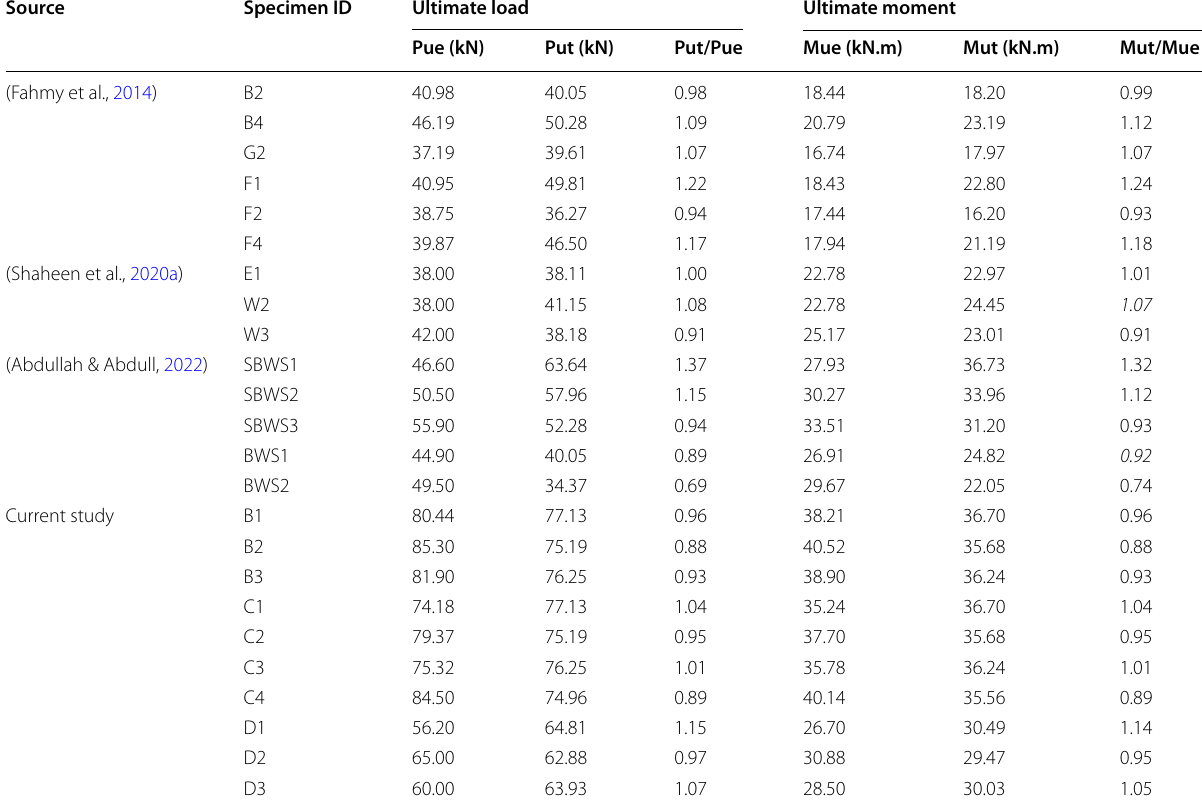
Table 11 Values of theoretical ultimate load and moment versus experimental ones